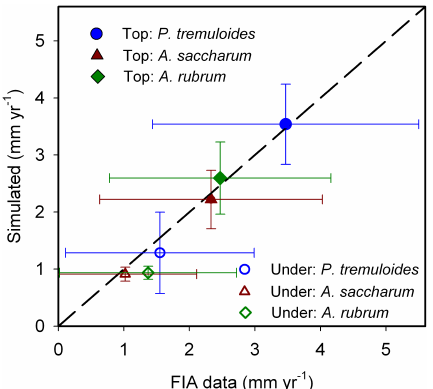
Figure 3. Simulated vs. observed DBH growth rates of three tree species in the upper canopy and the understory. Circles, triangles, and diamonds are for Populus tremuloides , Acer saccharum , and A. rubrum , respectively. Closed and open symbols are for upper- canopy (“Top”) and understory (“Under”) trees, respectively. The FIA data used to estimate observed growth rates are from the northern lake states (Michigan, Wisconsin, and Minnesota), USA. Canopy growth rates were estimated by combining trees with a re- ported crown class of “dominant” or “co-dominant”, and understory growth rates were estimated from trees with a crown class of “over- topped” (Zhang et al.,